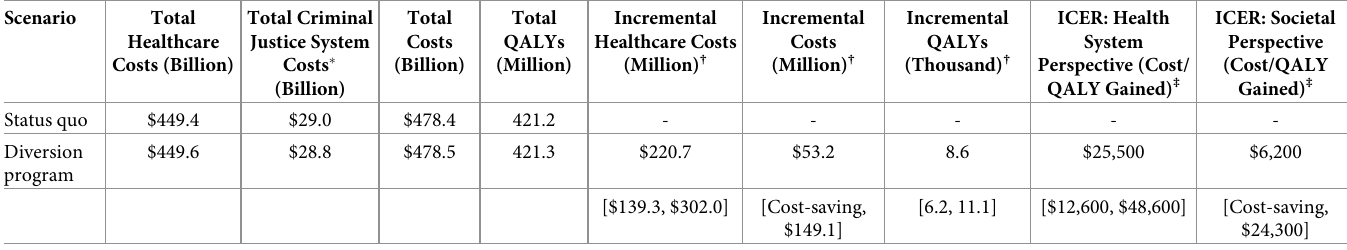
Table 4. Base case results: Costs and